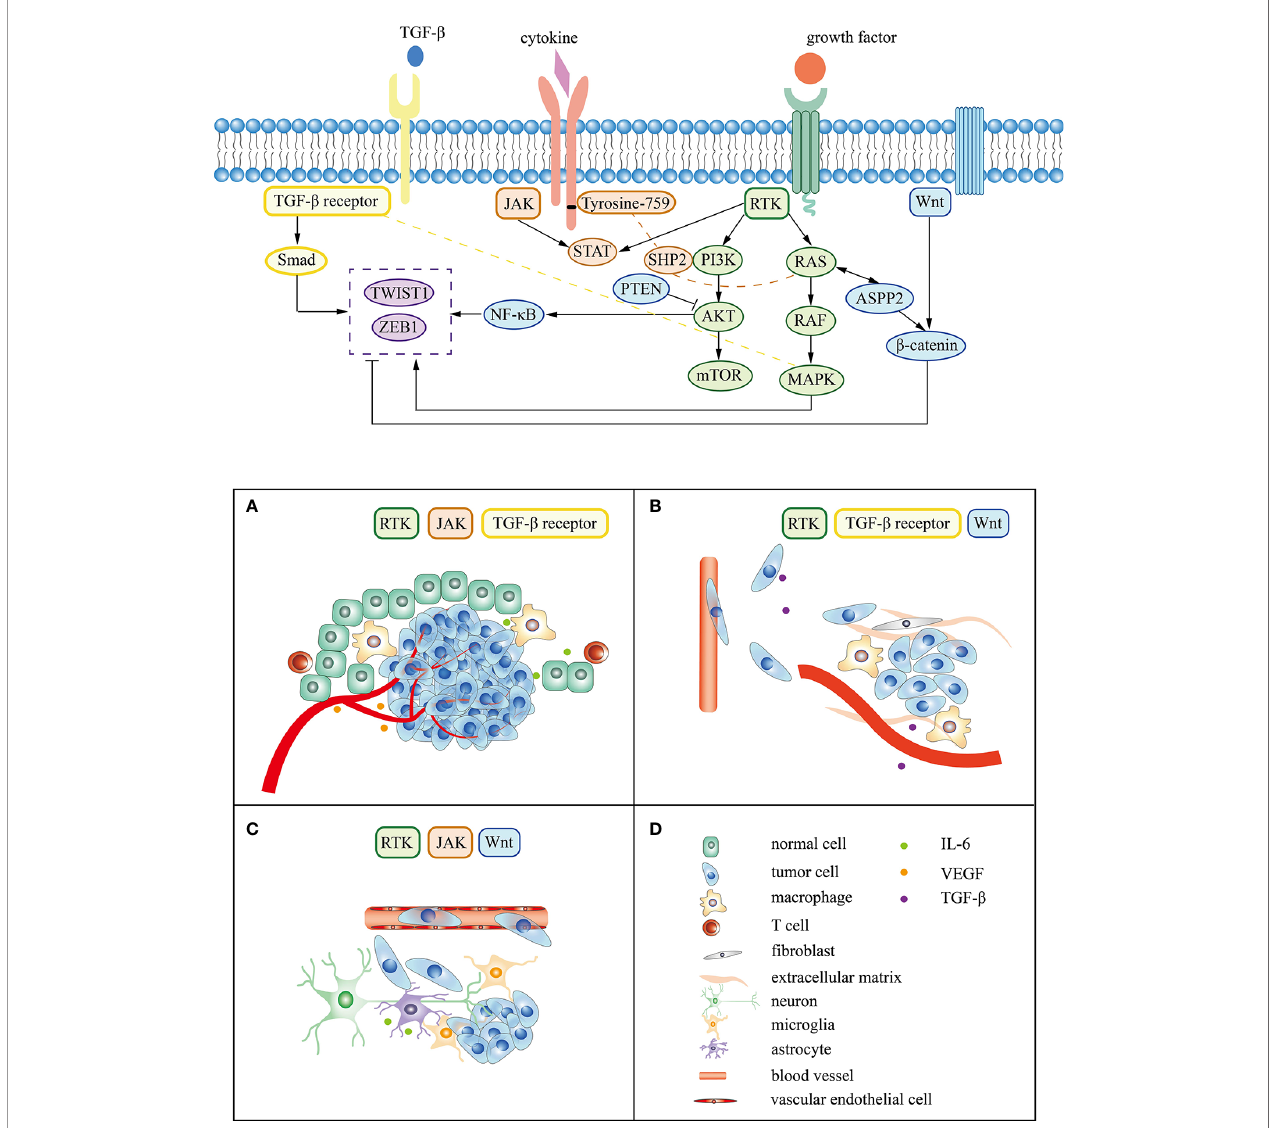
FIGURE 2 | Signaling pathway and mechanism related to lung cancer driver gene in brain metastasis. (A – C) represent the tumor cell survival, EMT, and colonization respectively. (D) corresponds to the cell or molecule in (A – C)